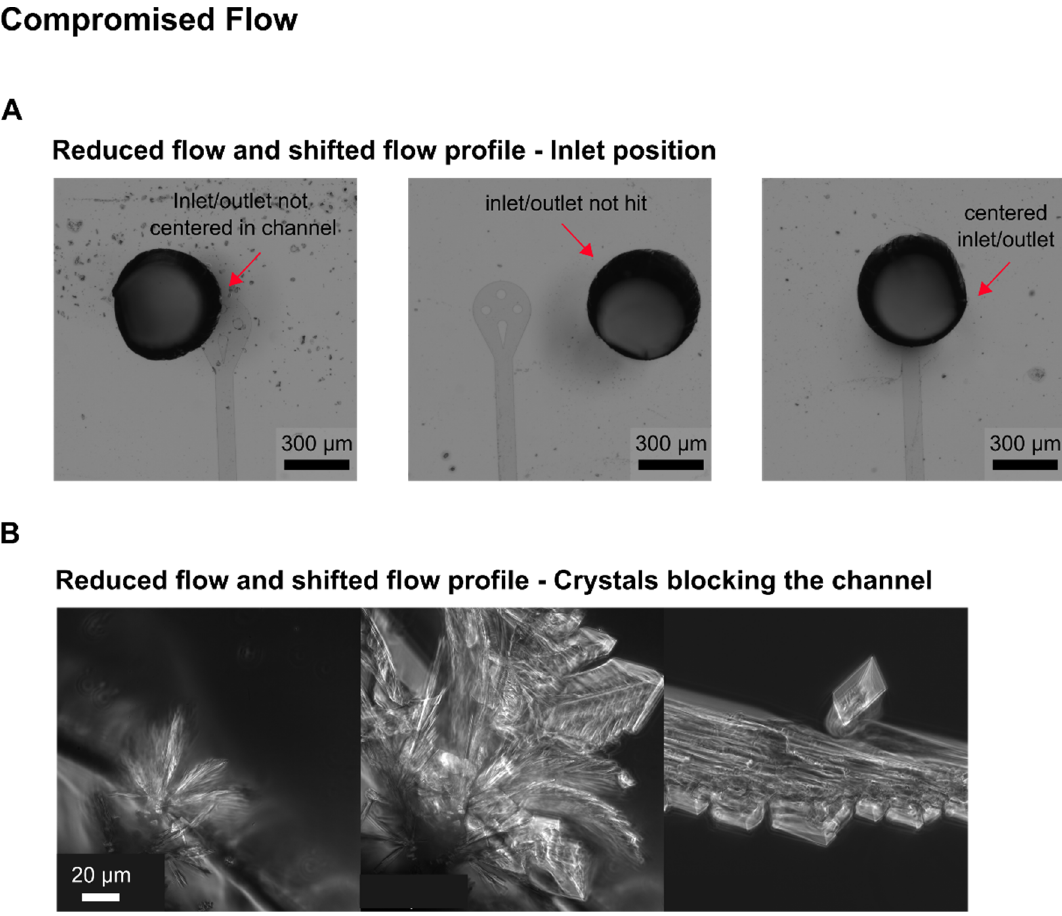
Figure A5. Example images of compromised flow (see Table 6). Microscope images of ( A ) reduced flow and shifted flow profile based on different inlet positions and ( B ) crystals that could block the channel and lead to a reduced flow and shifted flow profile.